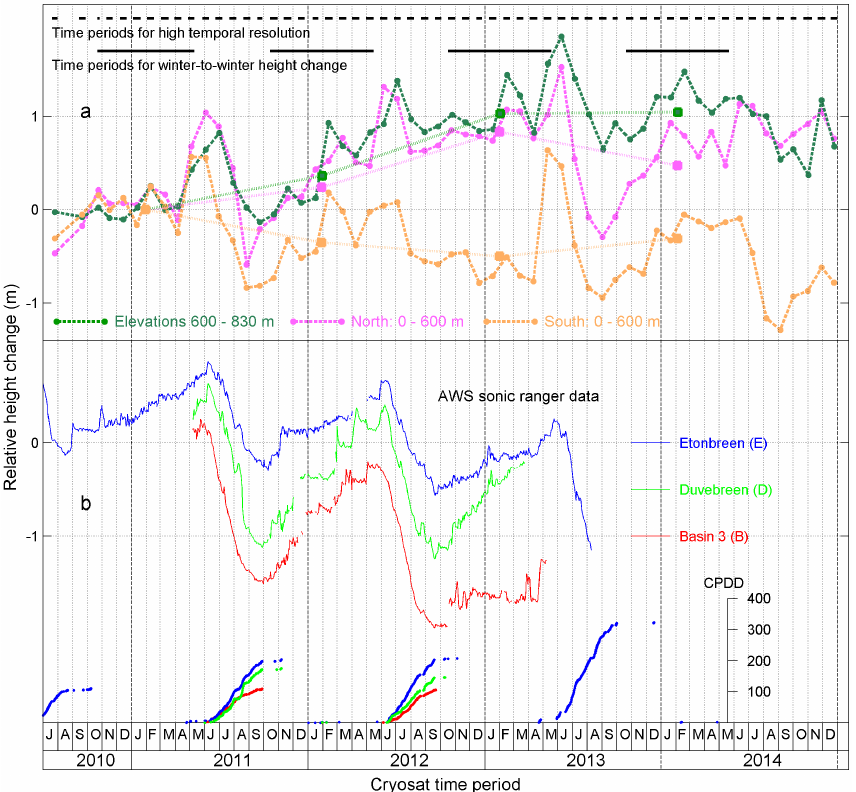
Figure 11. (a) CS2 height change plots for the three different areas illustrated in different colours in Fig. 10. The square markers indicate the height change for the larger temporal winter-to-winter time periods (October to May). Sonic ranger heights and cumulative positive degree day (CPDD) data from the 3 AWS sensors are shown in (b)